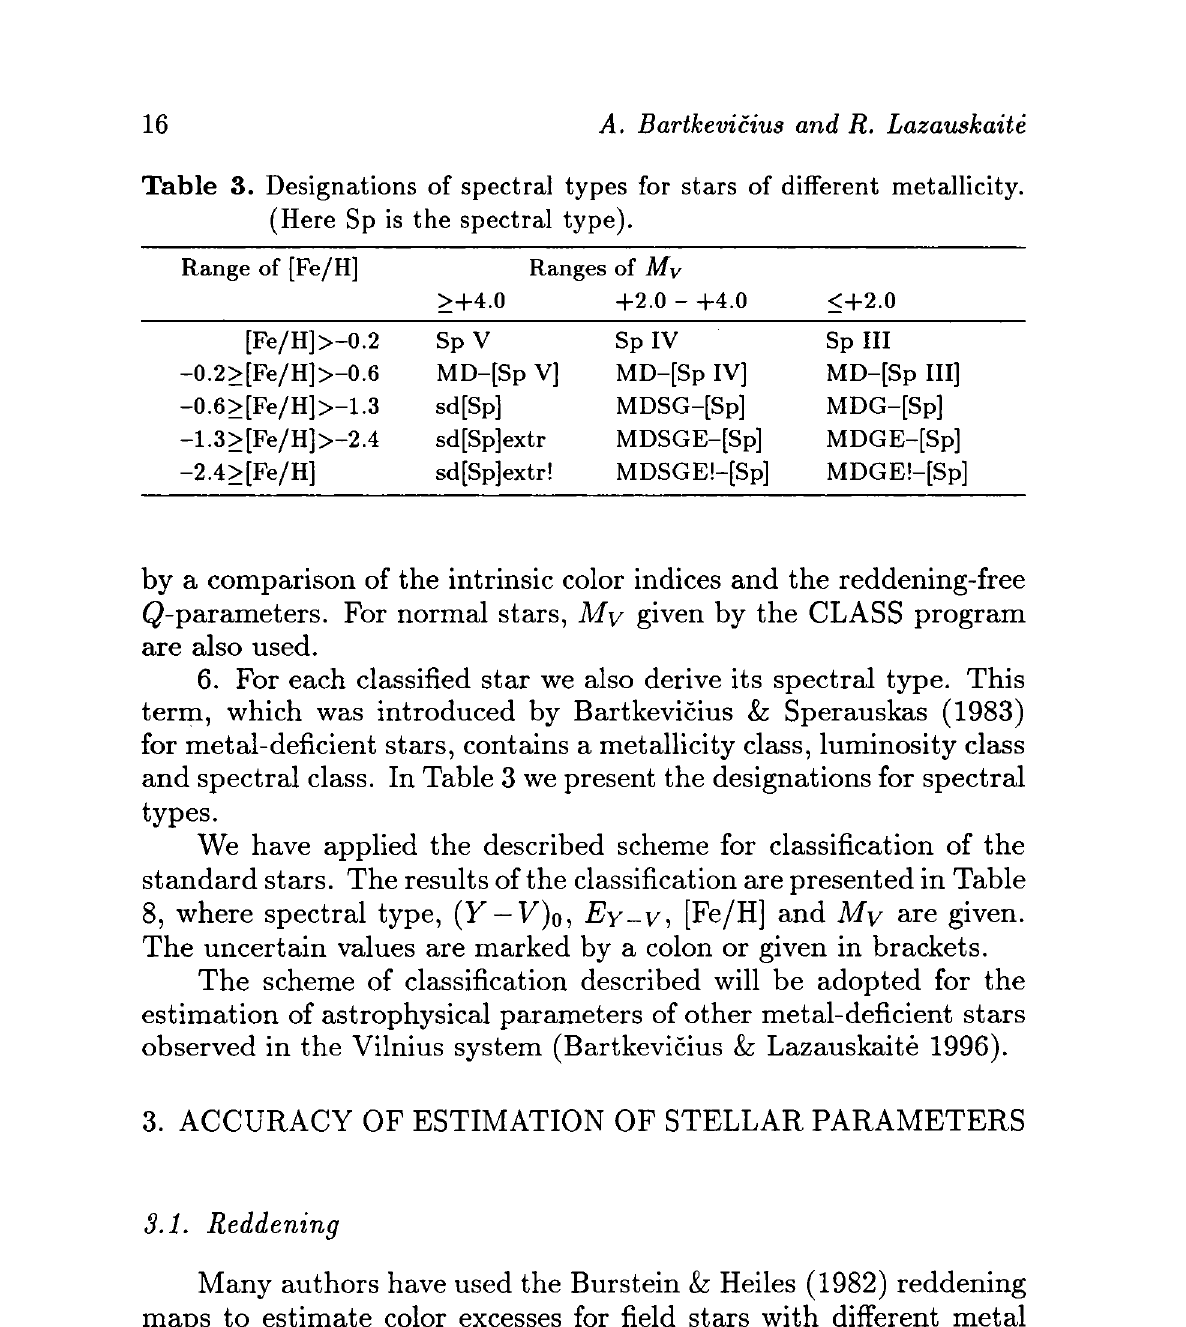
Table 3. Designations of spectral types for stars of different metallicity. (Here Sp is the spectral